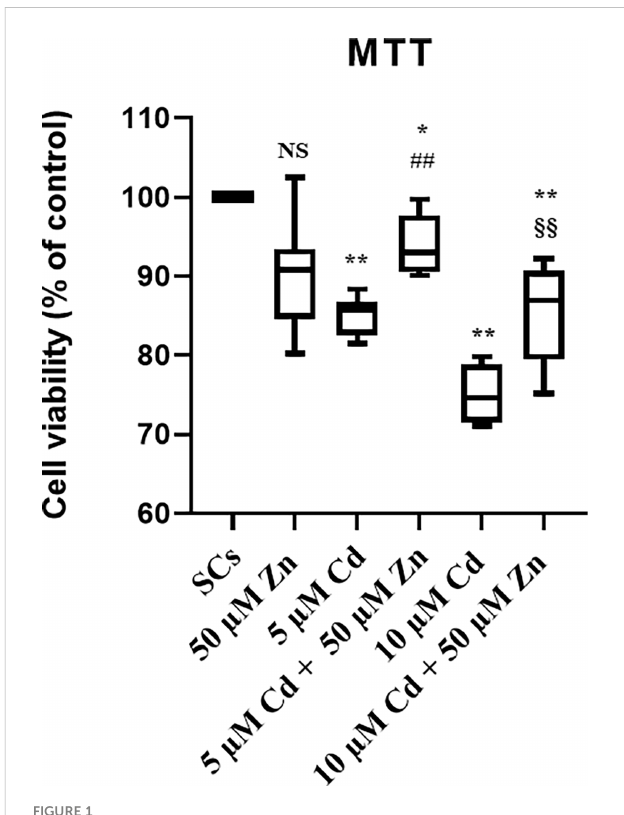
FIGURE 1 Cell viability by MTT test. Cytotoxicity, measured using MTT reagent in the absence (unexposed-control group, SCs) or presence of 5 or 10 µM CdCl 2 and/or 50 µM ZnCl 2 for 48 h. Data presented as the mean ± SEM (NS vs . SCs, * p < 0.05 and ** p < 0.001 vs . SCs, ## p < 0.001 vs . 5 µM Cd, §§ p < 0.001 vs . 10 µM of three independent experiments, each performed in